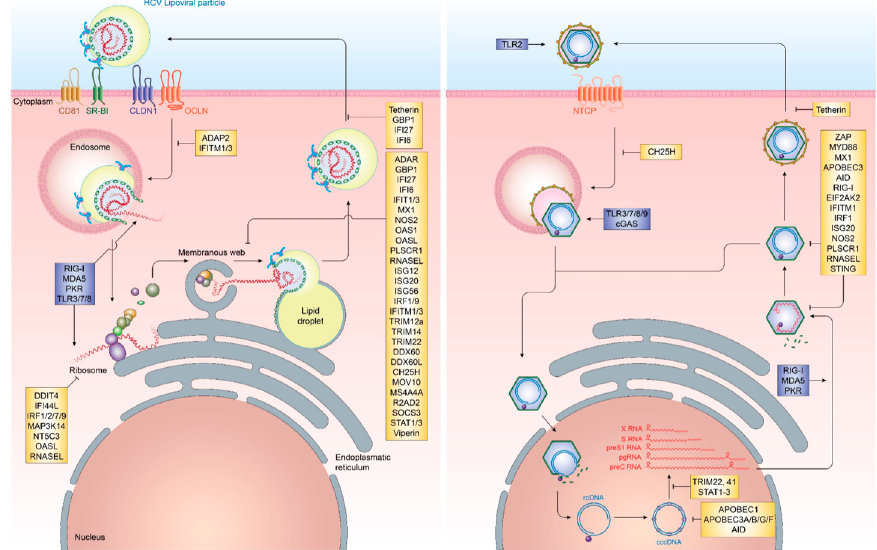
Figure 2. The life cycle of HCV and HBV and interferon effector molecules targeting different steps in the viral infection process. HCV (left) and HBV (right) life cycles including pattern recognition receptor targets (blue) and interferon-stimulated genes (yellow) affecting viral entry, replication and egress. Table 1. Interferon-stimulated genes with activity against HBV and HCV.